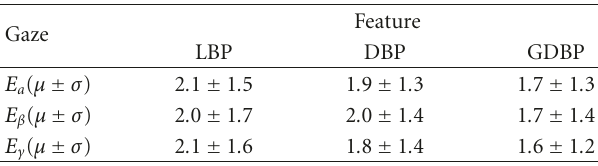
Table 1: Errors of three gaze directions under three lighting variations